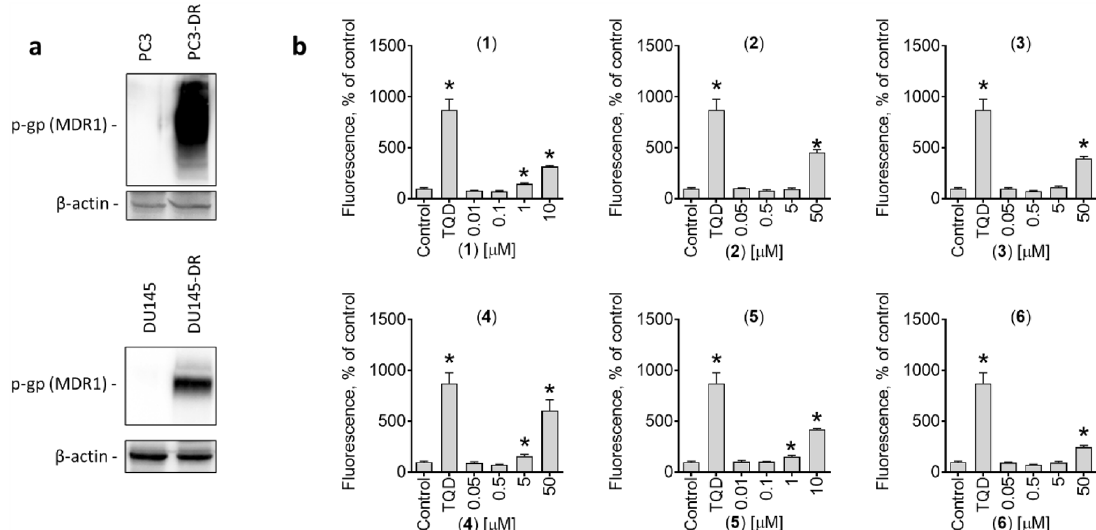
Figure 4. Effect on activity of p-glycoprotein (p-gp). ( a ), Western blotting analysis of p-gp expression in PC3, PC3-DR, as well as in DU145 and DU145-DR cells. The original full-size blots are represented in Supplementary Figure S19. ( b ), Green fluorescence measured in PC3-DR cells pre-treated with investigated compounds for 30 min and then further incubated with calcein-AM for 15 min. Tariquidar (TQD, 50 nM) was used as a positive control. *p < 0.05, one-way ANOVA